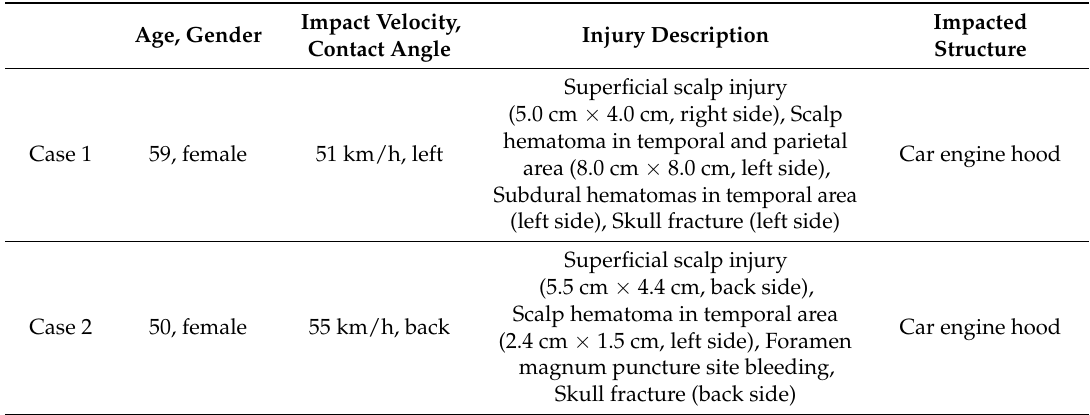
Table 1. Initial conditions for cases.